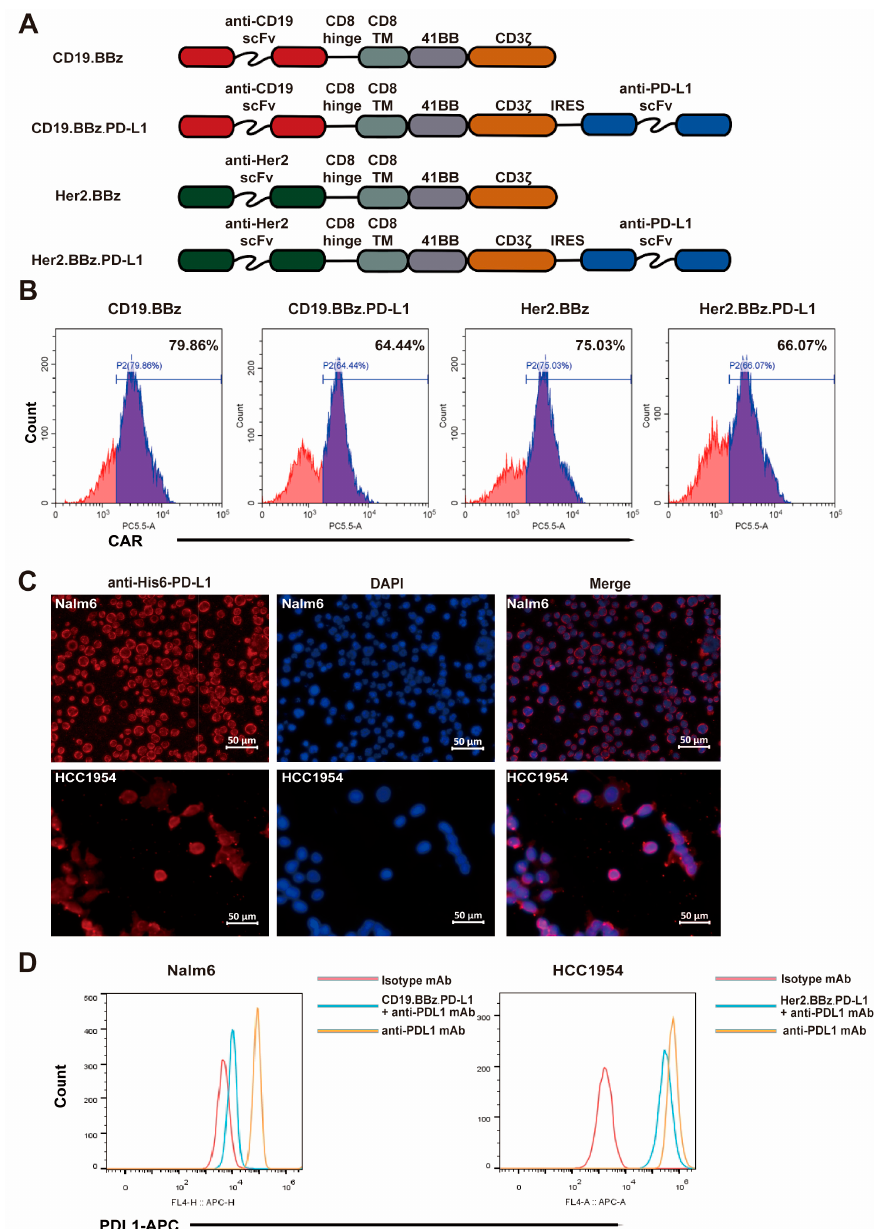
Figure 1. Generation and characterization of chimeric antigen receptor (CAR) T cells. ( A ) Schematic illustration of the CAR constructs designed in this study. ( B ) Flow cytometry analysis of CAR expression in T cells at three days after lentiviral transduction. ( C ) Programmed cell death ligand 1 (PD-L1) expression of Nalm6 and HCC1954 cells were detected with PD-L1 scFv Ab. ( D ) Competition of PD-L1 scFv with the PD-L1 antibody for binding to PD-L1 on Nalm6 and HCC1954 cells was measured by flow